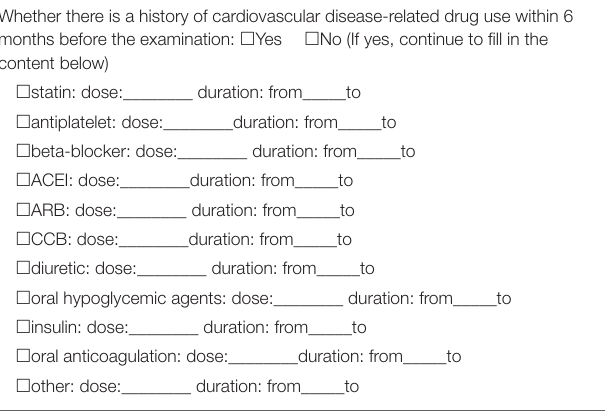
TABLE 3 | Baseline medications information. Whether there is a history of cardiovascular disease-related drug use within 6 months before the examination: (cid:3) Yes (cid:3) No (If yes, continue to fill in the content below)